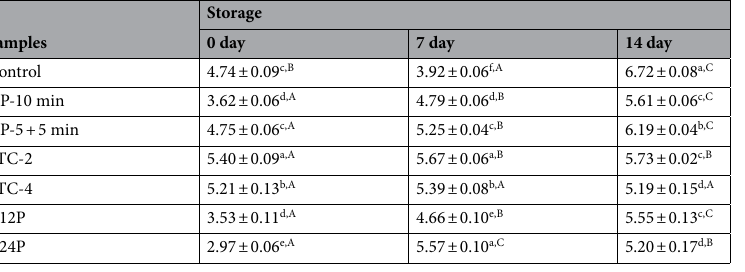
Table 3. 2-Thiobarbituric acid value (nmol/g) of brown rice processed with different treatments during storage. Values are means ± standard deviations (n = 3). Within columns, means followed by different letters are significantly different ( p < 0.05). Within rows, means followed by different capitals are significantly different ( p <